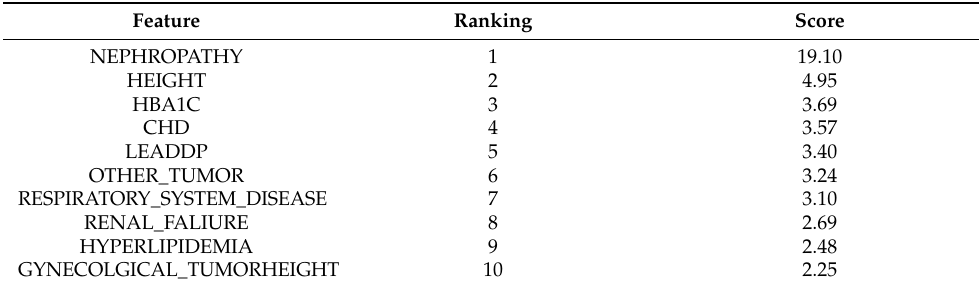
Table 7. Top 10 features of the XGB-Stacking model.